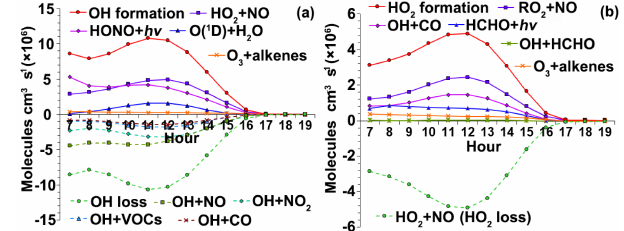
Figure 10. Average formation and loss pathways of OH and HO 2 at MK during the study period.